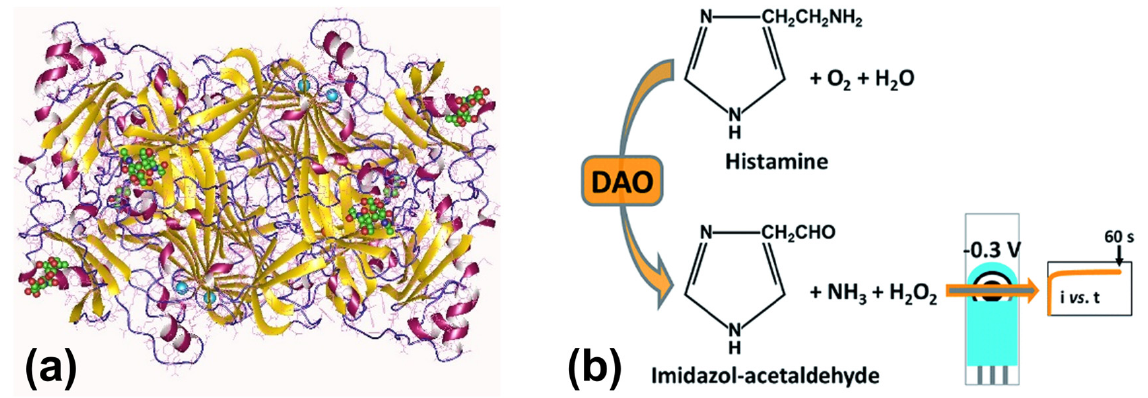
Figure 15. Working principle of enzymatic histamine detection. ( a ) Molecular structure of the DAO enzyme (human variant), the dimeric molecule has a total weight of 170 kDa [259]. The four calcium ions of the dimer are presented in light blue, the two copper ions in orange, and the 10 n-acetylglucosamine groups in green-red. ( b ) Enzymatic conversion of histamine to imidazole-acetaldehyde with NH 3 and hydrogen peroxide as additional educts. The electrochemical reduction of H 2 O 2 to water causes a cathodic current that is linearly proportional to the histamine concentration in the sample. ( b ) is adopted from ref. [256], by permission of the Royal Society of Chemistry, Copyright 2019.